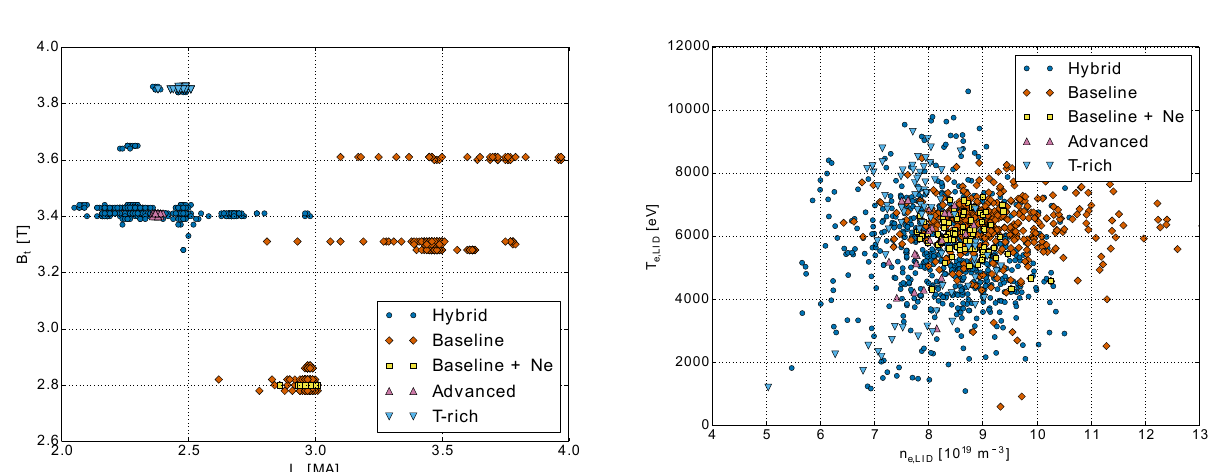
Figure 2: Plasma current ( I p ) and toroidal field B t of database points corresponding to flat-top phases for each pulse.